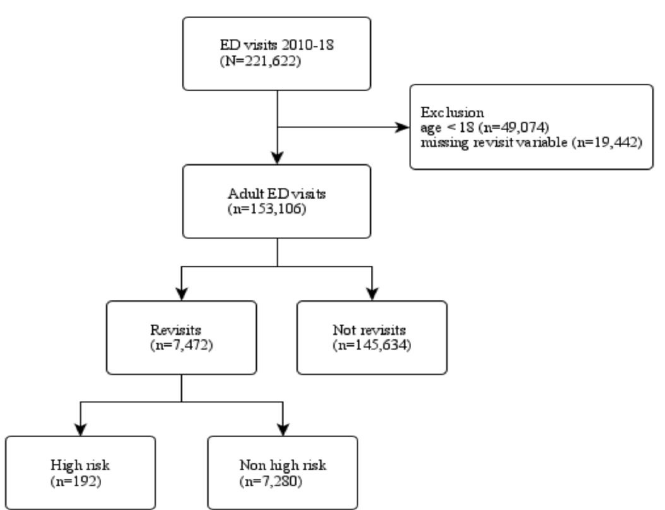
Figure 1. Patient selection